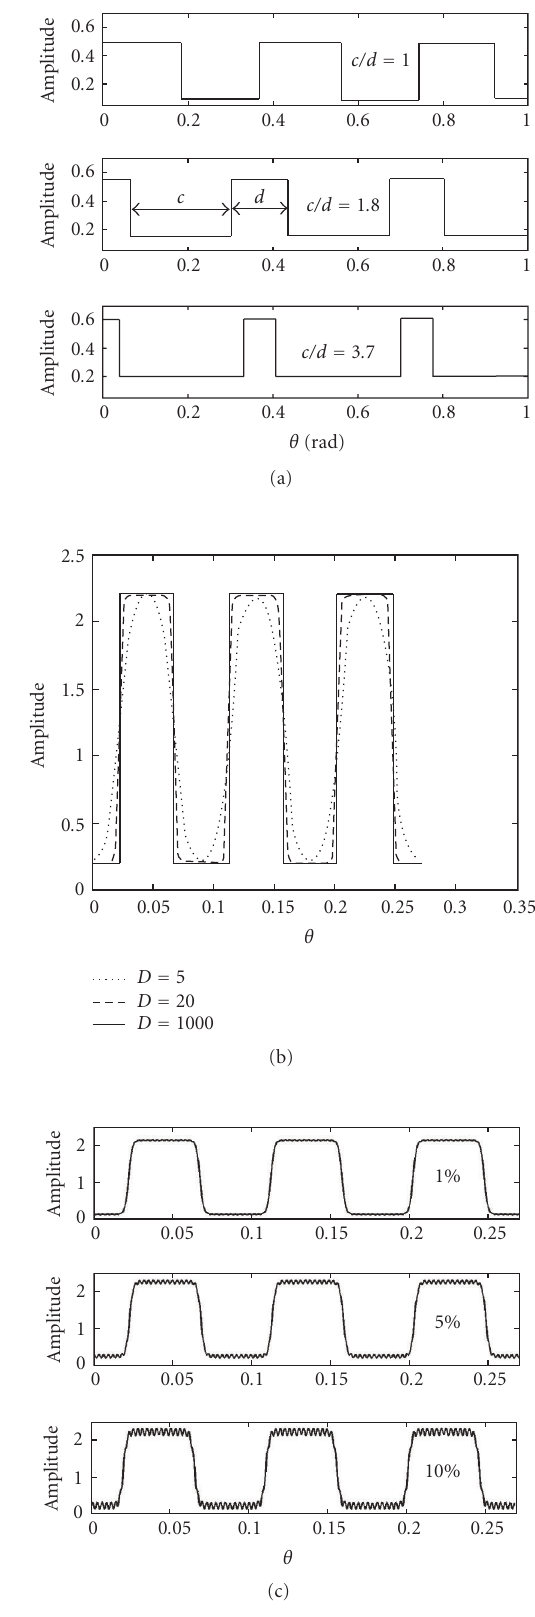
Figure 10: (a) c/d ratio, (b) jet-wake function steepness D , and (c) fluctuation